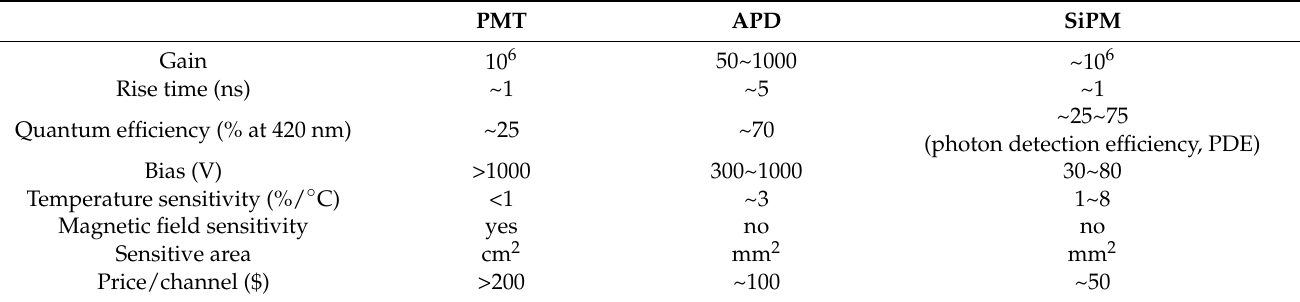
Table 2. Comparative table of three types of optical sensors